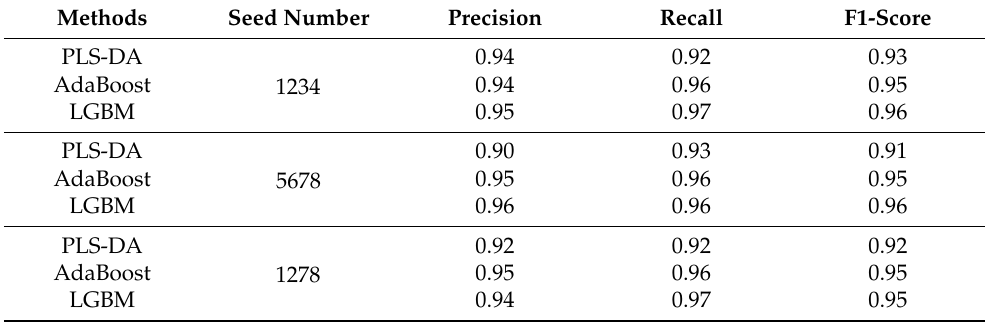
Table 2. The precision, recall, and F1-score values of the established models for CYP3A4 properties.